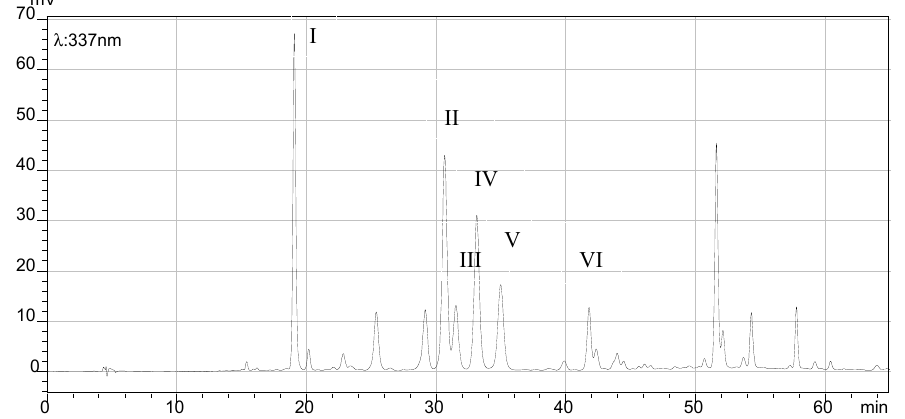
Figure 5. HPLC chromatogram of the crude flavonoid extracts ( λ = 337 nm). The peaks were identified as chlorogenic acid (I), 2 ″ - O - β - D -xylopyranosyl isoorientin (II), 6- C - α - L -arabipyranosyl orientin (III), orientin (IV), isoorientin (V), and vitexin (VI).